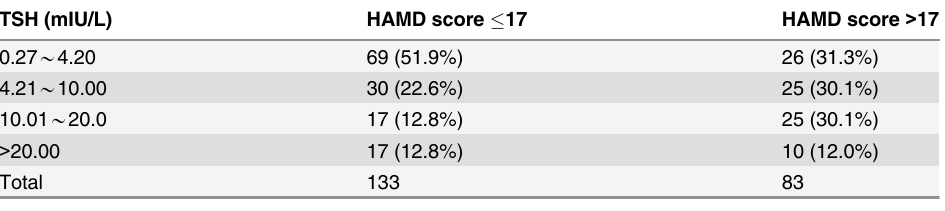
Table 2. Relationship between HAMD score and TSH levels in Graves ’ disease patients after 131 I treatment.